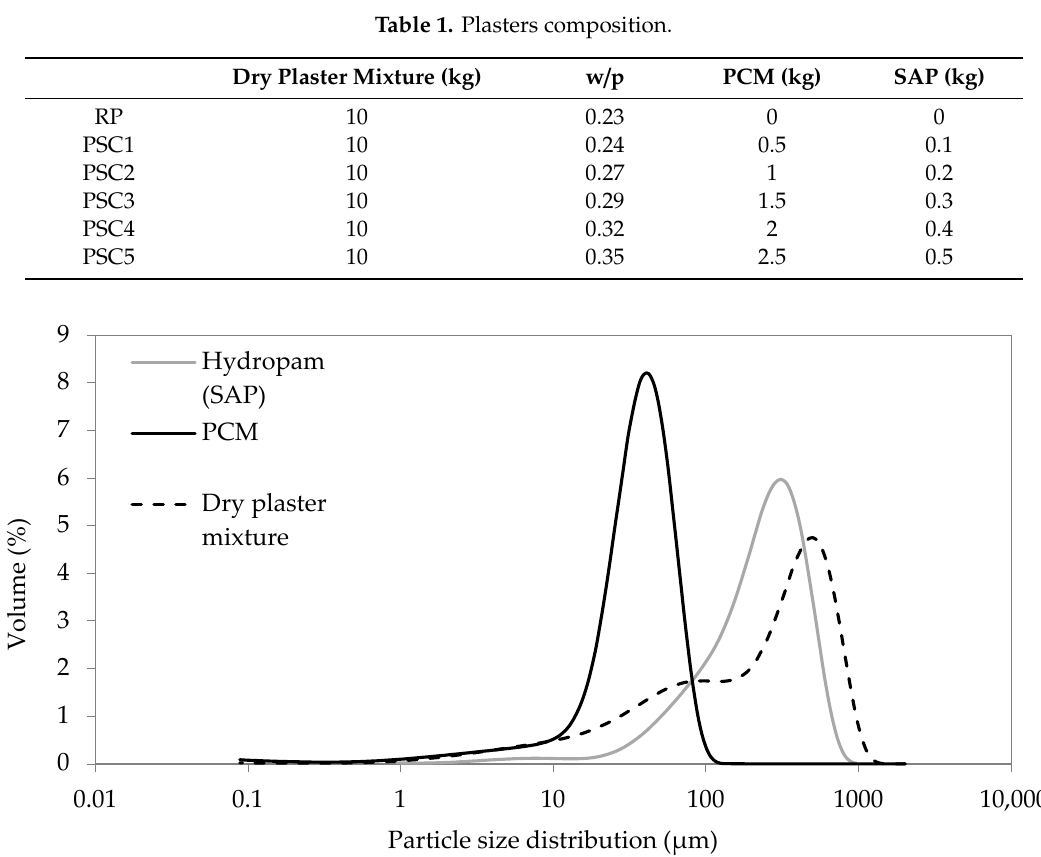
Figure 2. Particle size distribution of used PCM composite, SAP, and dry plaster mixture.